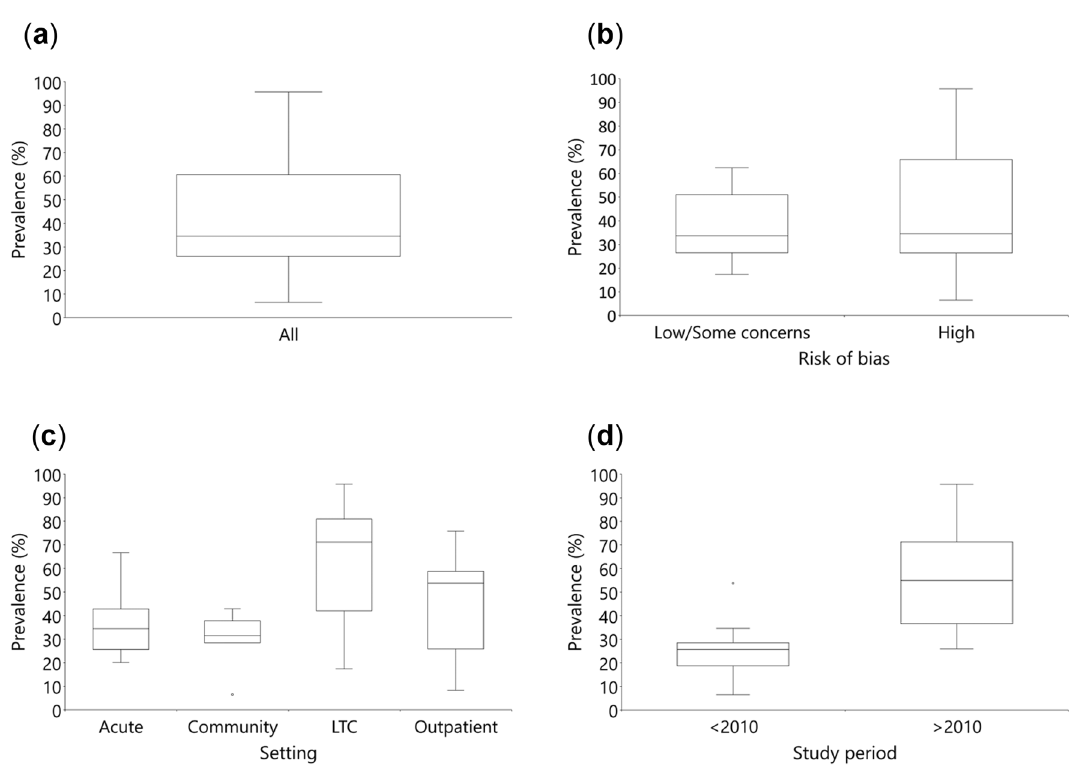
Figure 3. Box-and-whisker plots of prevalence of potentially inappropriate prescribing ( a ) for all outcomes, ( b ) separately by the overall risk of bias, ( c ) separately by the setting, ( d ) separately by the study period. LTC Long- term